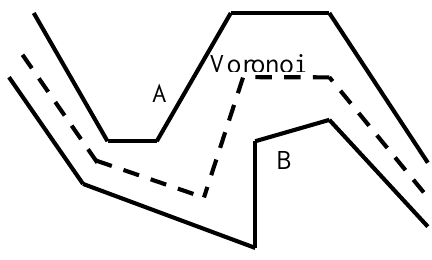
Fig. 3. Principle of the Voronoi-based model used to describe direc- Fig.3 Principle of the Voronoi-based model tion relations between single used to describe direction relations between single objects.